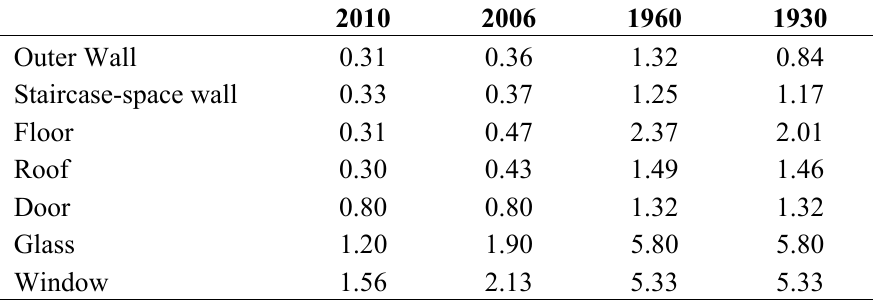
Table 1. U-values [W/m 2 K] of external structures for the different construction